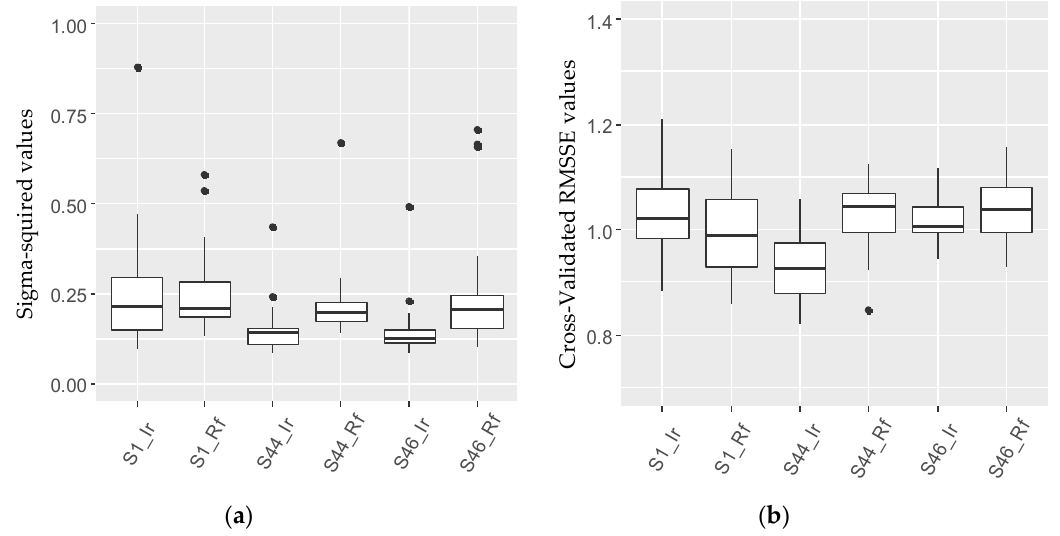
Figure 3. Box plots of ( a ) σ 2 and ( b ) cross-validated root-mean-squared standardized error (RMSSE) values of the emulator build for three soil types (S1, S44 and S46) and irrigated (Ir) and rainfed (Rf) condition: The thick black lines indicate the median, the boxes indicate the interquartile range (IQR), the whiskers indicate 1.5 times the IQR and the black points indicate outliers beyond 1.5 times the IQR. Computed cross-validated RMSSE values of emulators ranged between 0.82 and 1.21 (Figure 3b). These values were lower than the values reported by Kennedy et al. [47] and Petropoulos et al.